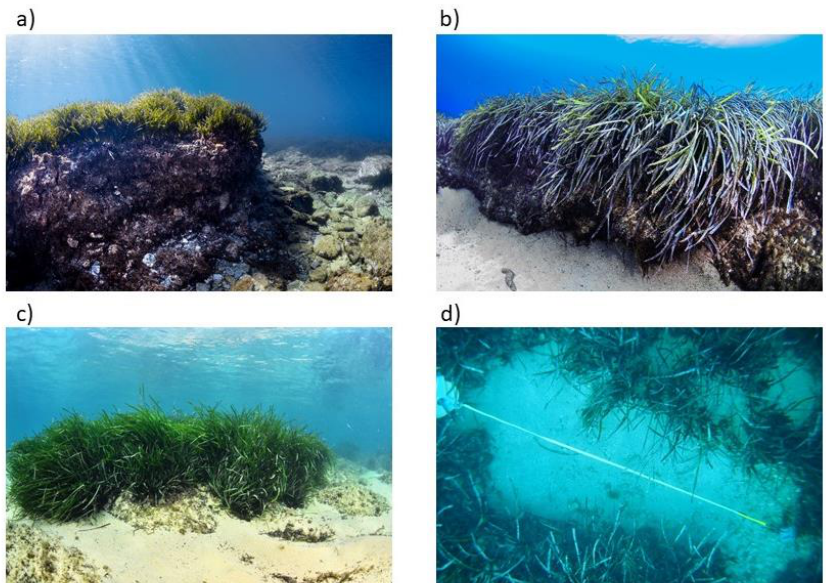
Figure 1. Photographs of the structural edges of a canopy: the upper limit of a canopy ( a ) and the lower limit of a canopy ( b ). On photograph c we present a patch of vegetation and on the photograph ( d ) a gap within a canopy, with the edge being the boundary between the non-vegetated (sandy bottom) and the vegetated zones. The photographs were taken by Xavier Salvador. Photographs were taken in Cala Vigatà ( b – d ) and in Cala Rostella ( a ), both in the northwestern Mediterranean Sea.